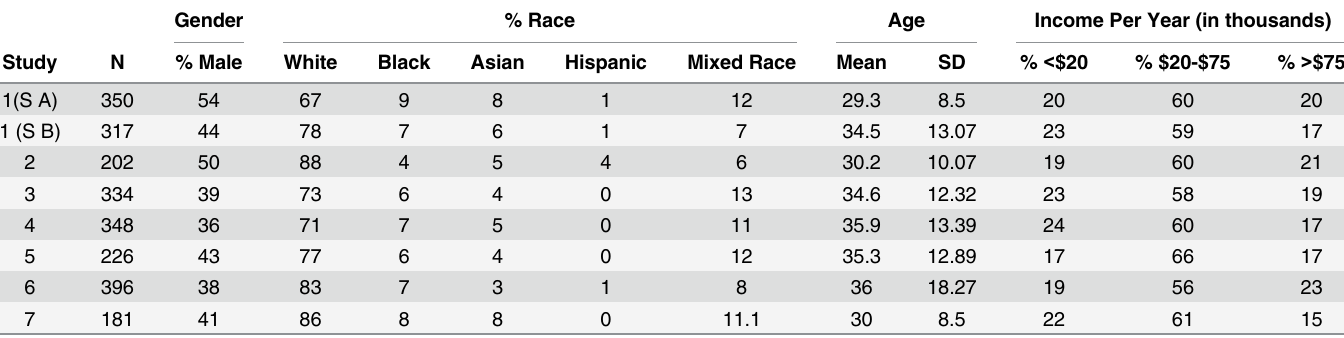
Table 1. Characteristics of Samples 1 –